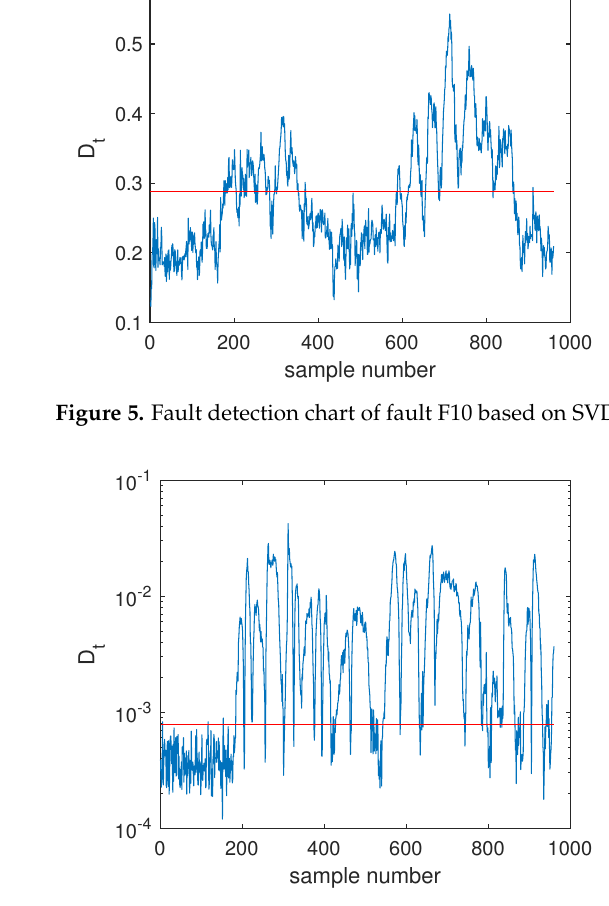
Figure 6. Fault detection chart of fault F10 based on deep SVDD